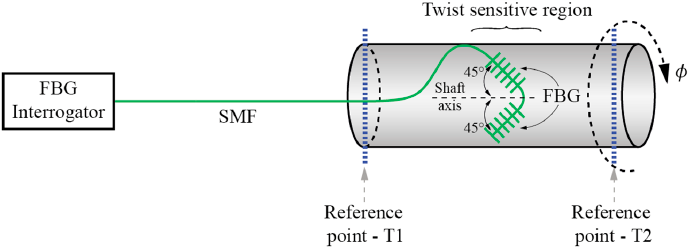
Figure 26. Schematic setup of differential configuration of FBG sensor at 45° angle relative to the shaft axis.